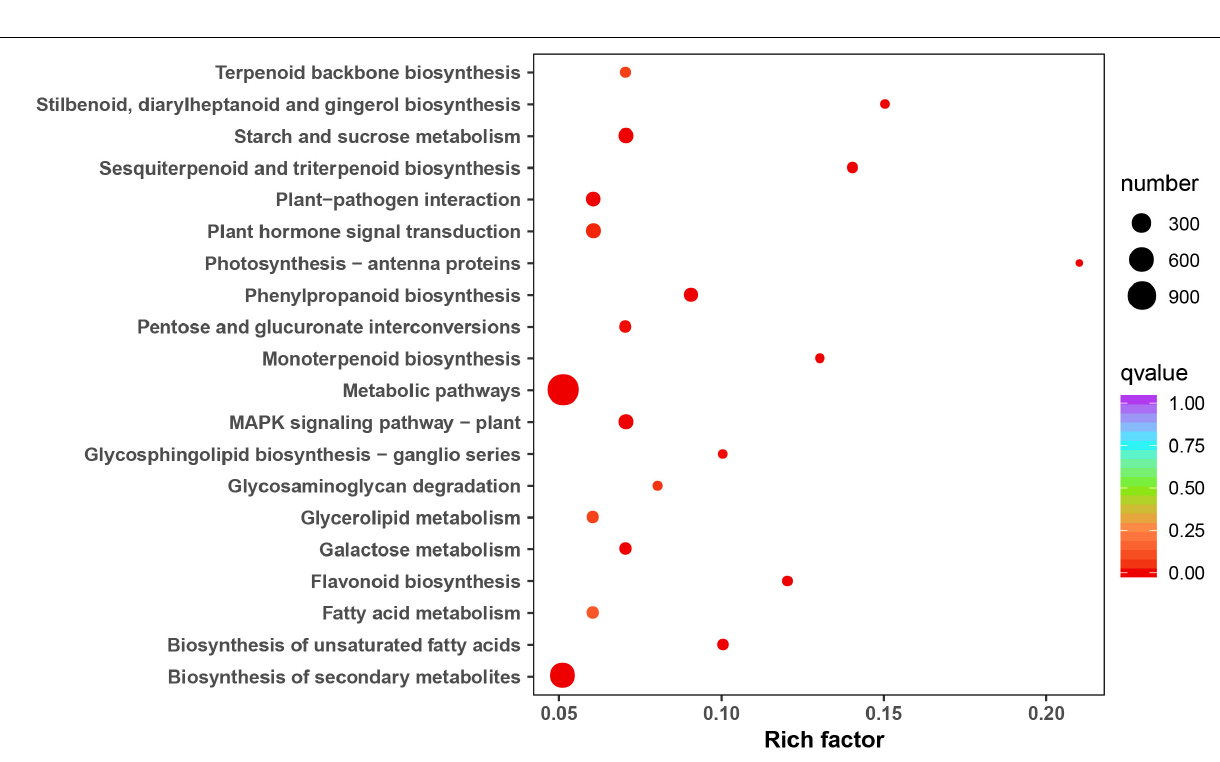
FIGURE 3 | Gene ontology (GO) functional classifications of differentially expressed genes (DEGs) of A-J vs. B-J.